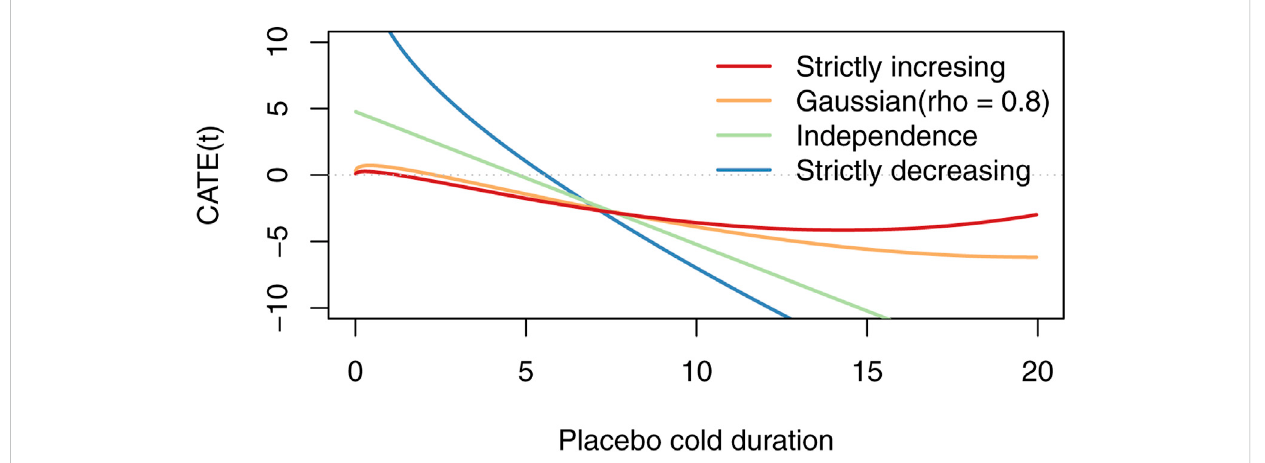
Possible CATE curves for the zinc data set when the correlation of the Gaussian copula varies. Hemilä et al. (2022), (Figure 2(B)) based their analysis onalinesimilartothe “ strictly increasing ” line,butusednon-parametericestimatorsforthequantilefunctions insteadofmaximumlikelihoodforgamma and